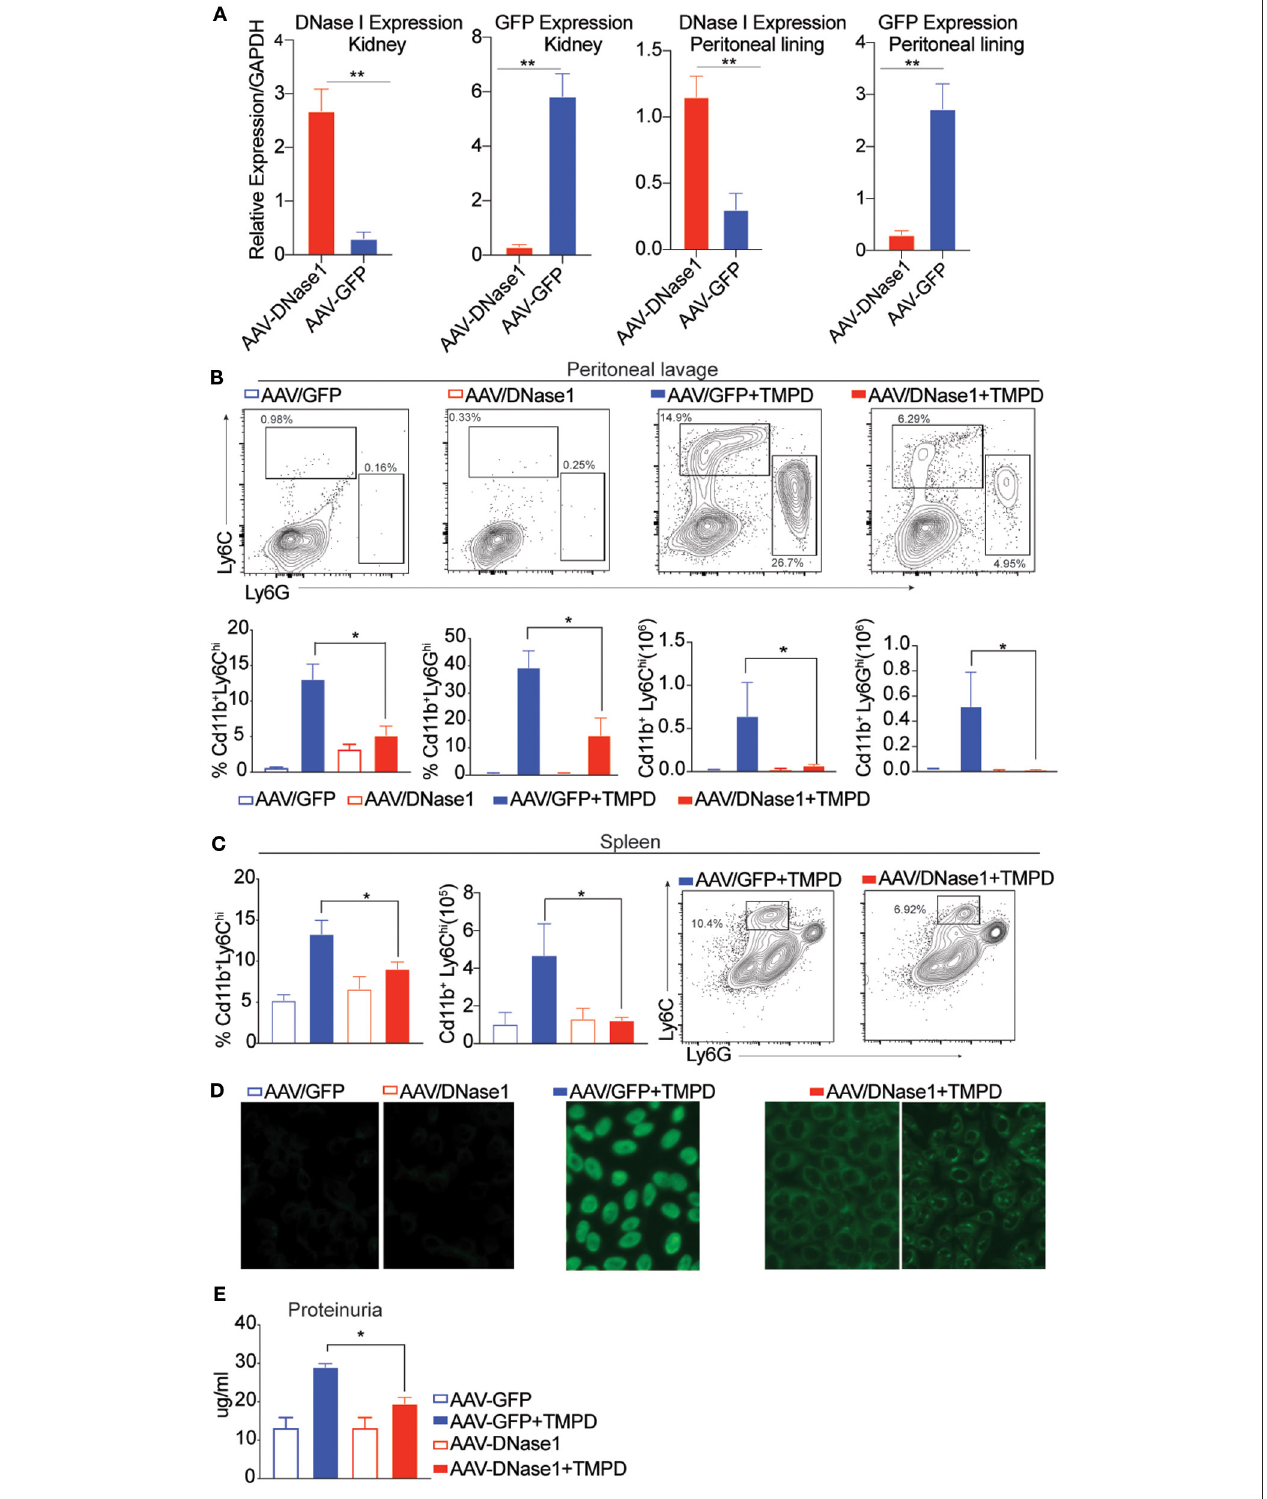
FIGURE 1 | Overexpression of DNAse I ameliorates inflammation in chronic TMPD mediated peritonitis. 8–10 weeks old female C57BL6/J WT mice were either injected i.p. with 10 11 AAV/GFP or AAV/DNAseI particles in 200 uL PBS. 10 weeks later mice were either injected with 500 ul TMPD or un-injected and analyzed